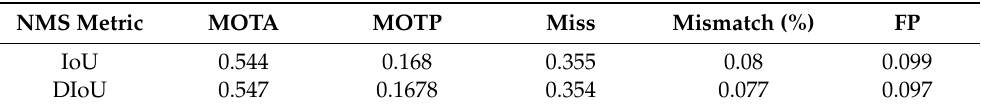
Table 2. Comparison of the tracking results for vehicle objects using different NMS metrics on the validation set of Waymo Open Dataset.